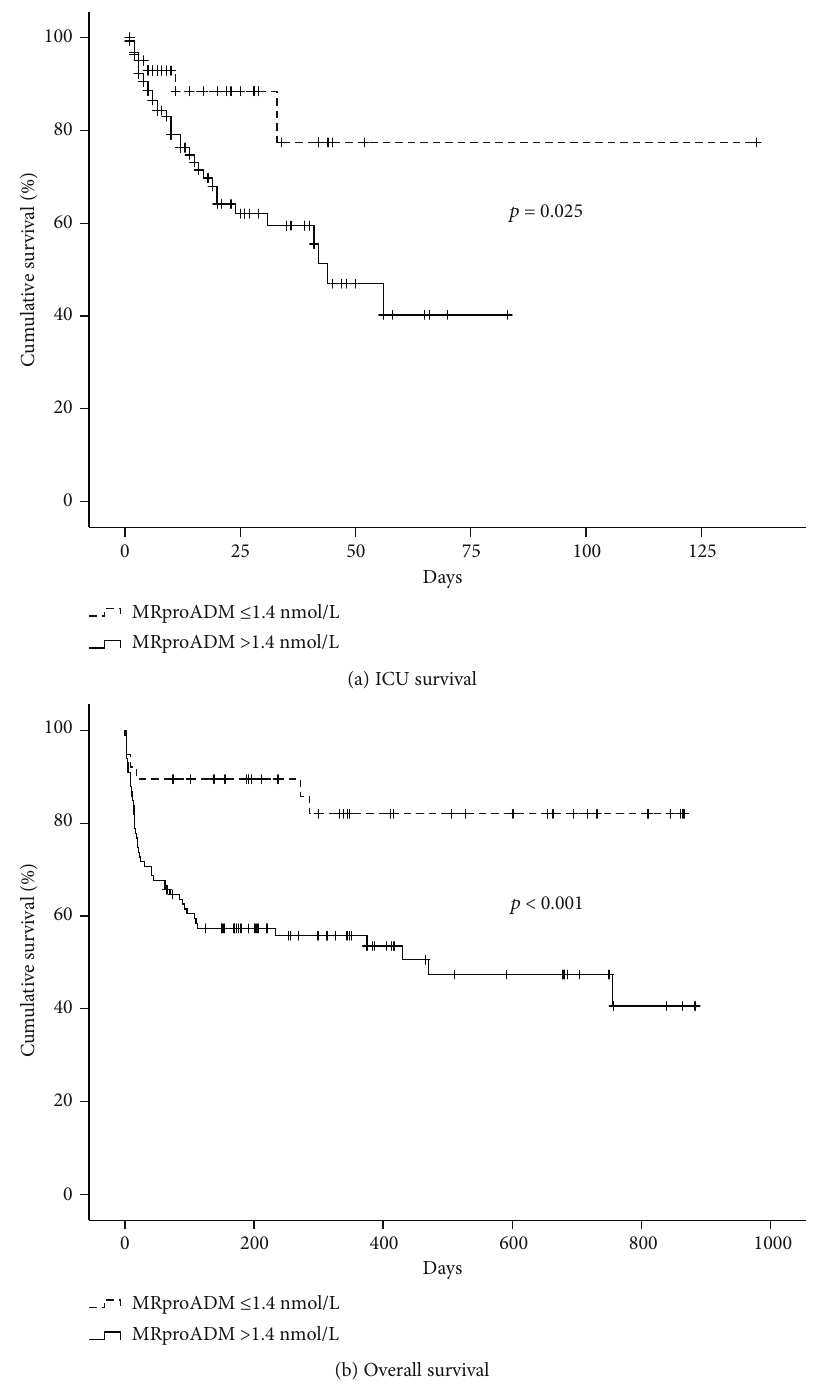
Figure 3: Prediction of ICU mortality by MRproADM serum levels. (a) Kaplan-Meier survival curves of ICU patients are displayed, showing that patients with MRproADM serum levels below a cut-o ff value of 1.4nmol/L showed better outcome at the ICU ( p = 0 : 025 , Log-Rank-test). (b) Kaplan-Meier survival curves of ICU patients are displayed, showing that patients with MRproADM serum levels below a cut-o ff value of 1.4nmol/L showed better outcome during follow-up ( p < 0 : 001 ,